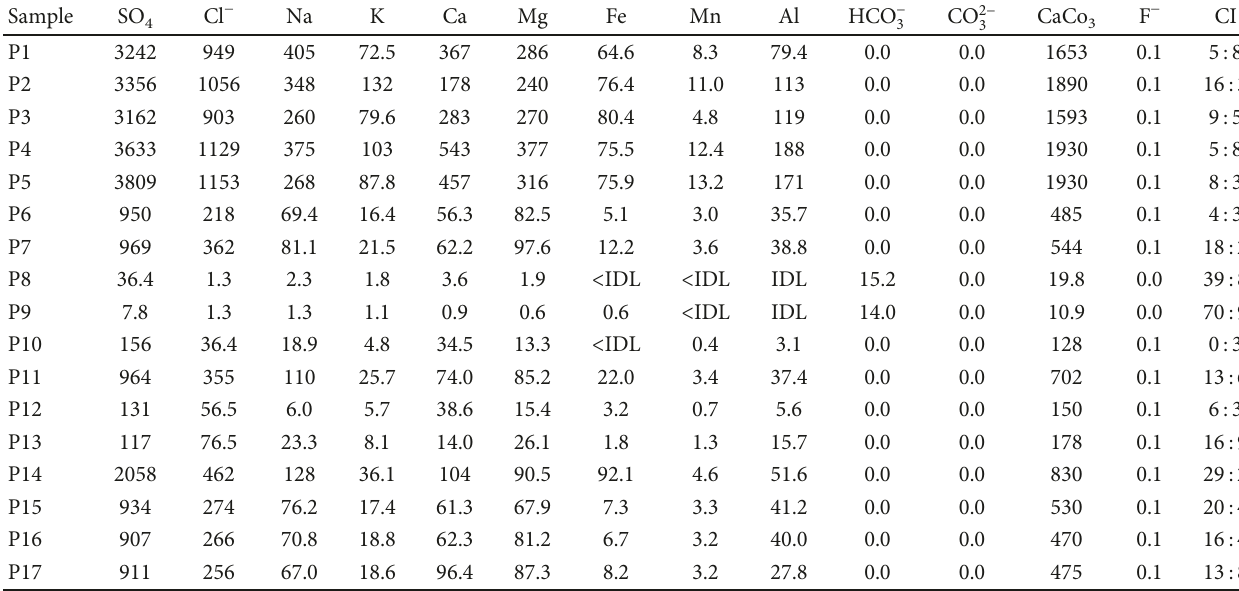
Table 3: Major element concentrations of the geothermal waters from the Puracé-La Mina sector, Cauca, Colombia. Units are in ppm, total hardness (CaCo ), less than detection limit ( < DL), not detectable (ND), and charge imbalance (CI). 3